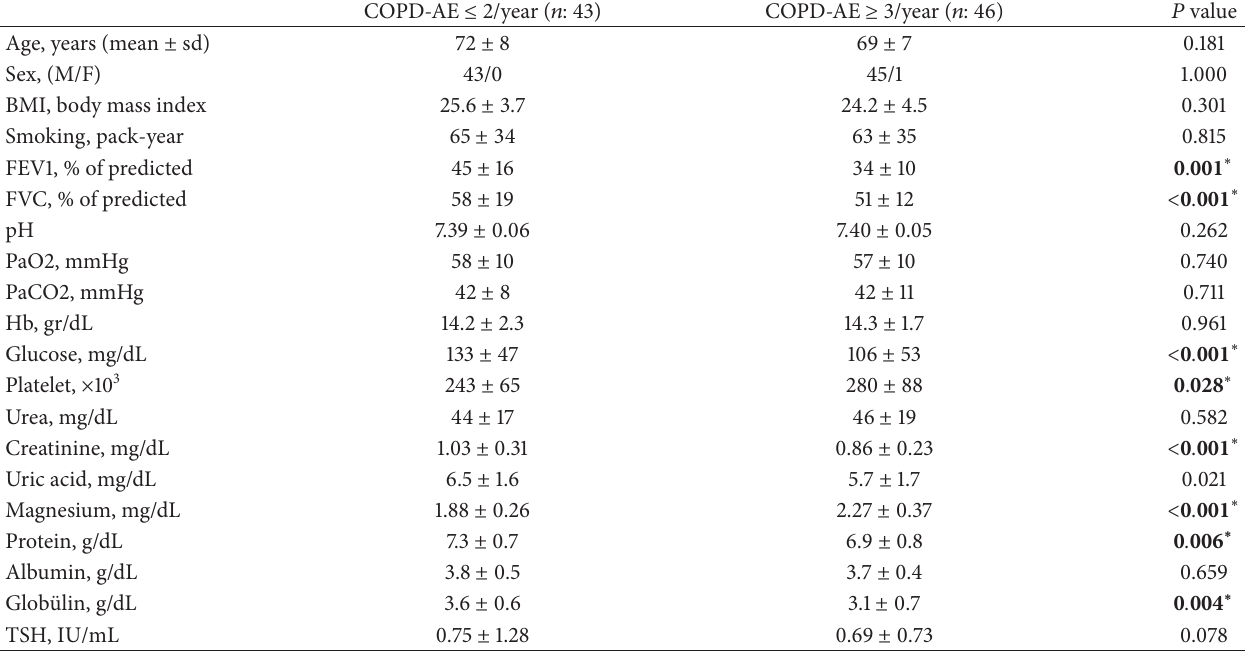
Table 3: Comparison of variables between groups established on the basis of number of